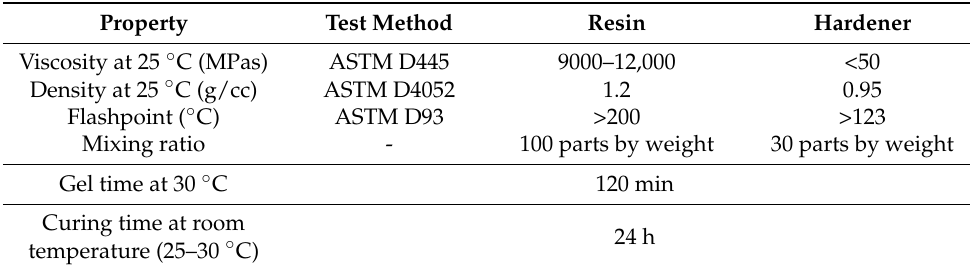
Table 2. Typical properties of resin and hardener.